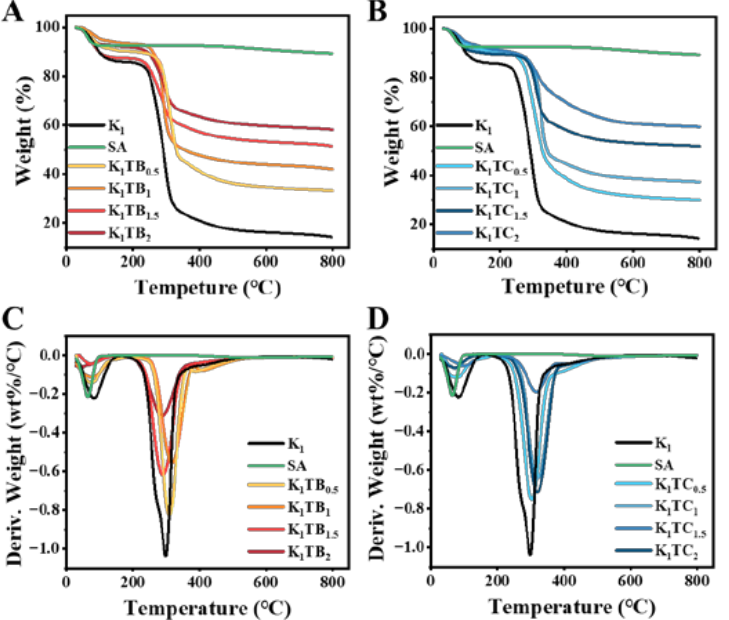
Figure 8. TG ( A , B ) and DTG ( C , D ) curves of KTB aerogels and KTC aerogels.